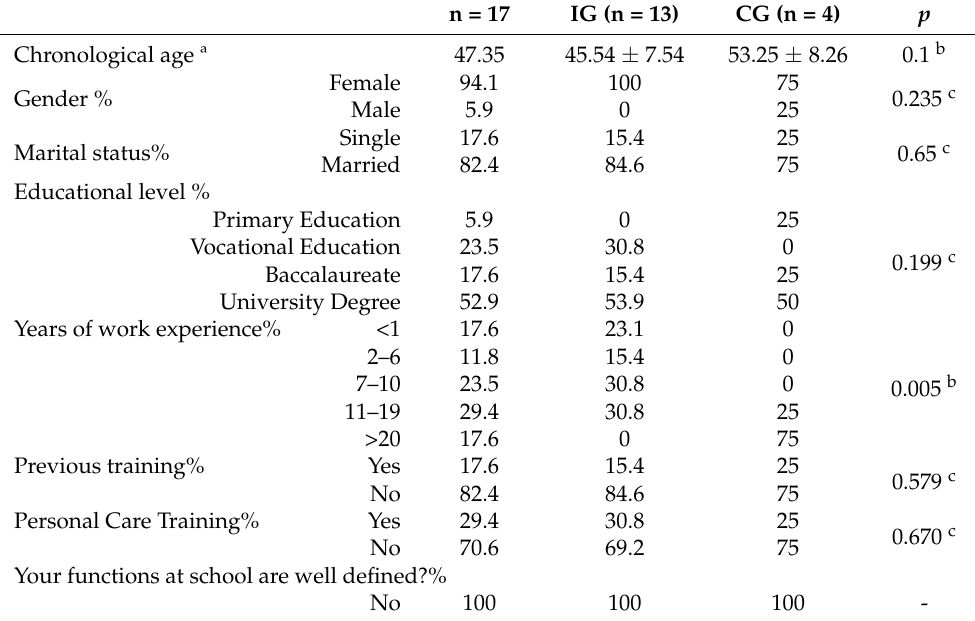
Table 1. Demographic Characteristics of